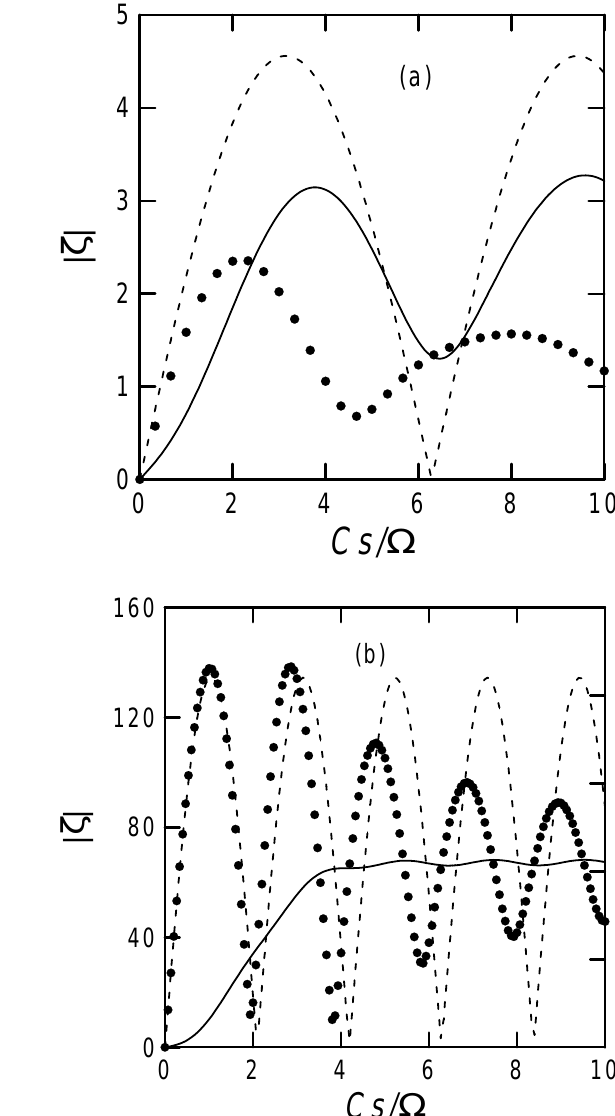
FIG. 2. Dependences of the amplitude j z j [(a) dimensionless] and phase [arg (cid:115) z (cid:100) (b)] of oscillations on the distance along the beam. For (a) from top to bottom (cid:116) (cid:173) (cid:67)(cid:115) (cid:121) V (cid:173) (cid:49) , 0.5, and